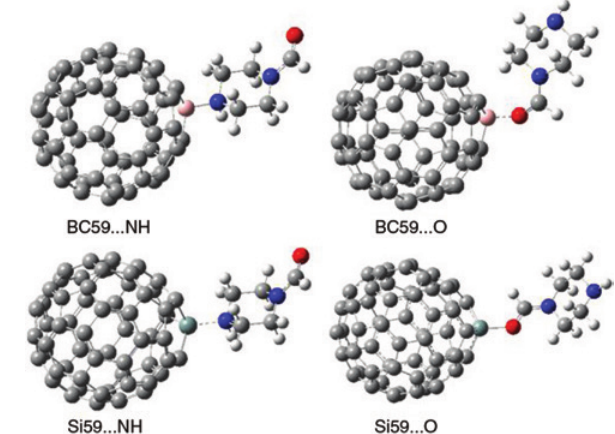
Figure 2: Optimized molecular structures for the investigated systems by M062X/6-31G(d) in the gas phase.